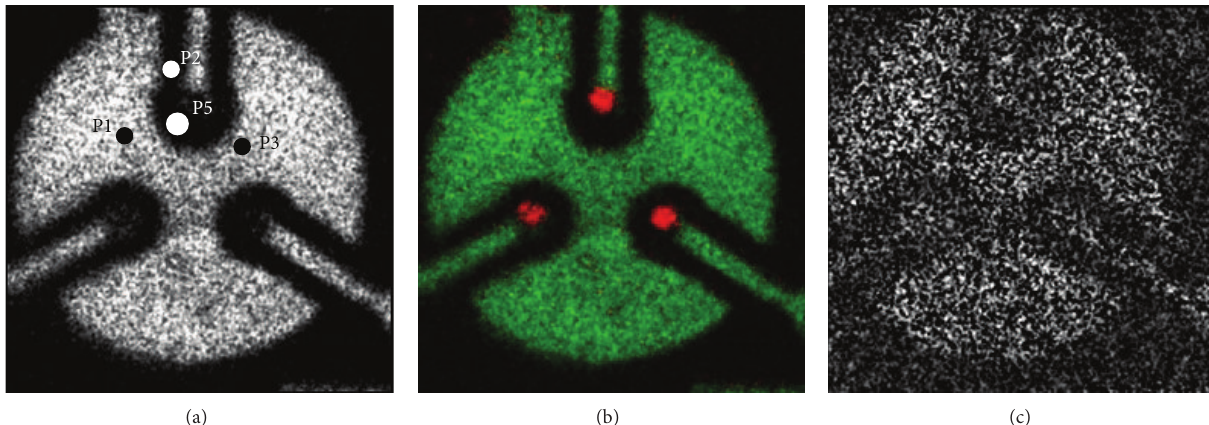
Figure 7: XPS mappings of the fixed base of DS switch: (a) Au 4f (XPS survey spectra were collected in marked points P1–P3 and P5), (b) Au 4f (green color) and Rh 3d (red color), and (c) Cu 2p.